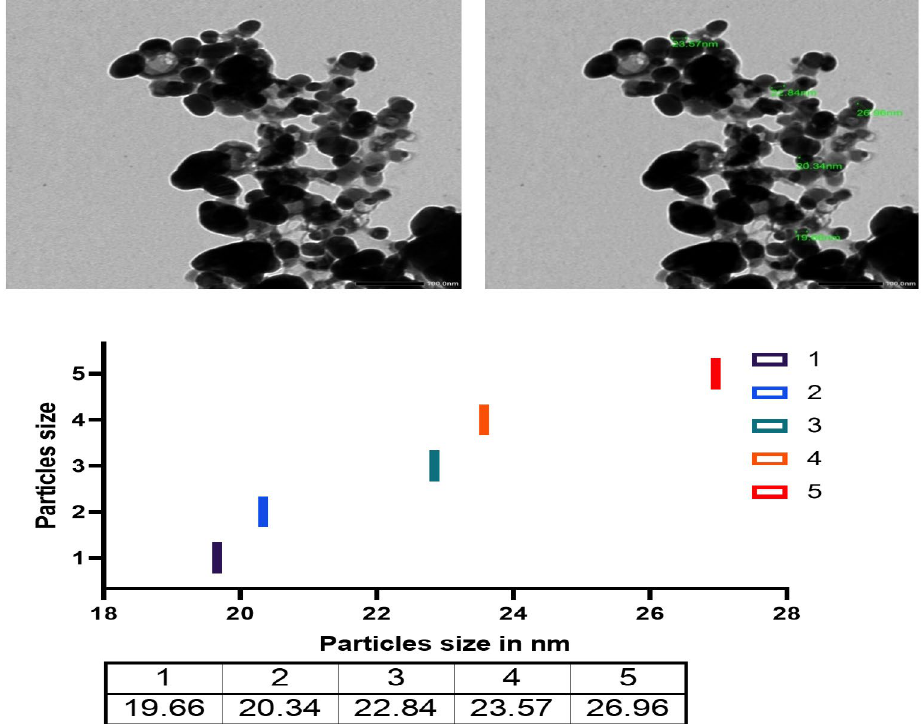
Fig. 14. TEM micrograph and diameter distribution graphic of the Ag-NPs obtained with the Bacillus maritimus using nutrient broth